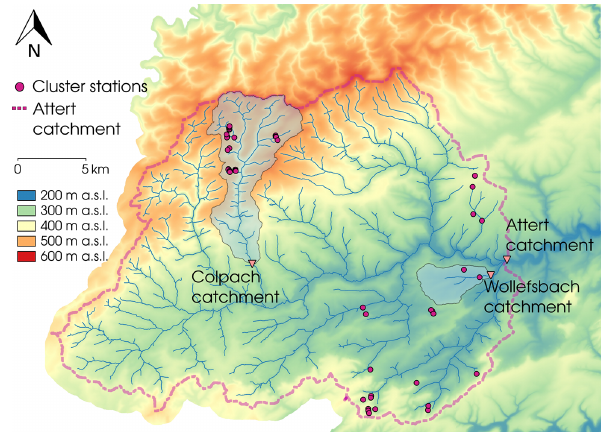
Figure 1. Map of the Attert basin with the two selected headwater catchments of this study (Colpach and Wollefsbach). In addition, the cluster sites of the CAOS research unit are